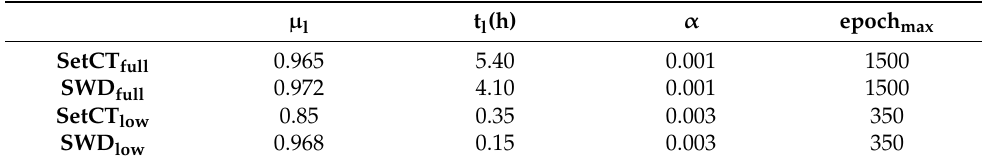
Table 1. CNN’s learning parameters and results.